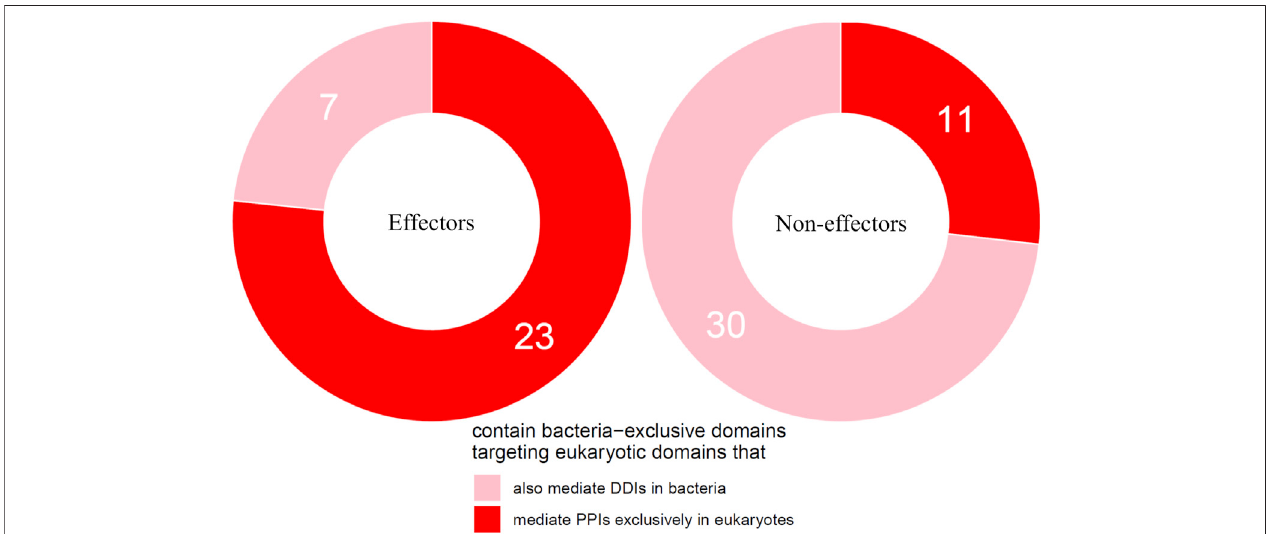
FIGURE4| Effectorsareenriched forbacteria-exclusivedomains targeting hostdomains thatotherwise mediateDDIs exclusively ineukaryotes.Among pathogen proteins containing bacteria-exclusive domains with the potential to target host domains that mediate DDIs in eukaryotes, 77% effectors and 27% non-effectors target host domains that mediate DDIs exclusively in eukaryotes, suggesting that effectors are nine times as likely as non-effectors to disrupt eukaryote-speci fi c processes via bacteria-exclusive domains (Fisher ’ s exact test, two-tailed p (cid:2) 4 * 10 − 5